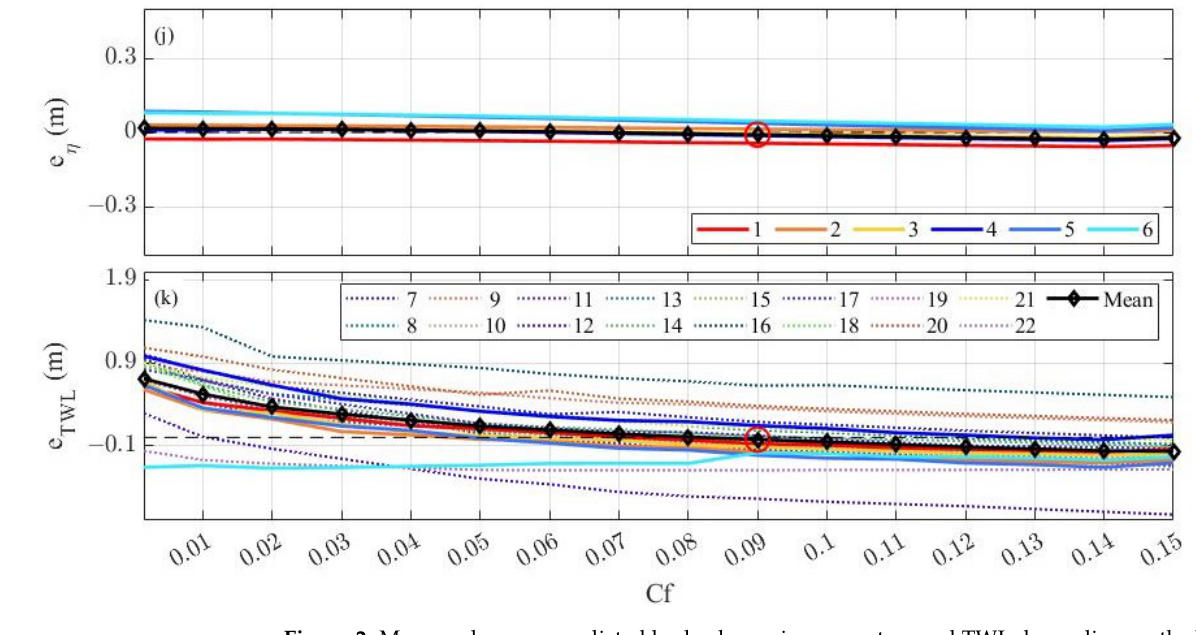
Figure 2. Measured versus predicted hydrodynamic parameters and TWL depending on the bottom friction coefficient ( Cf ). Error between measured Hrms/modelled Hrms, ( a , d , g ) on the front reef position, ( b , e , h ) on the reef crest position, and ( c , f , i ) on the reef flat and ( a – c ) for SW band ( e Hrms SW ), ( d – f ) for IG band ( e Hrms IG ), and ( g – i ) for VLF band ( e Hrms VLF ). ( j ) Measured/modelled wave-setup ( η ) in the reef flat. ( k ) Camera-derived total water level (TWL) against modelled TWL. On graphs ( a – j ) only the 6 events extracted from field measurements are plotted. On graph ( k ) the 16 storms extracted from the whole camera dataset are also plotted. The bold black line with diamonds represents the mean error on all storms for each Cf value modelled. The red circle on each plot indicates the Cf value (0.09) chosen after calibration.